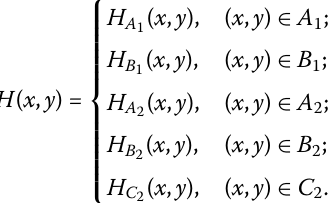
Step 7 : Set x 1 = ¯ x , y 1 = y 1 /2, f 1 ( y ) = H B